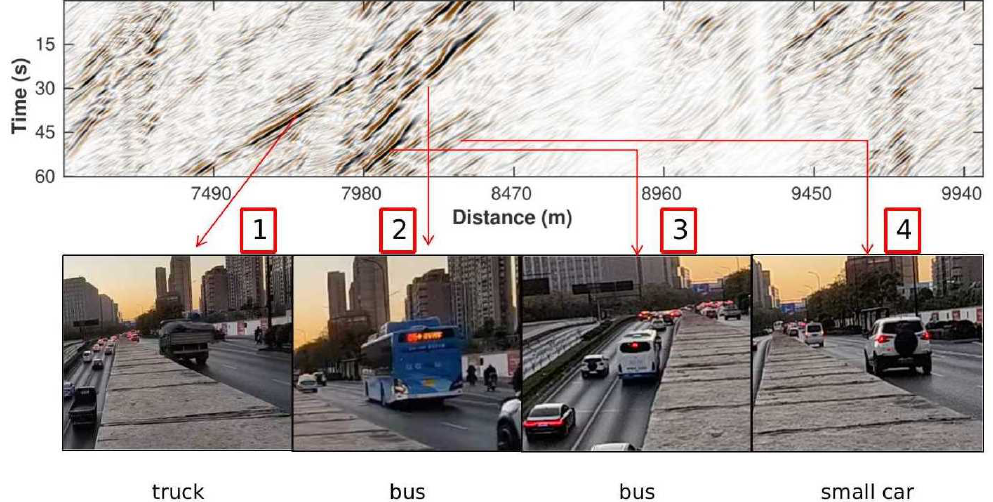
Figure 15. The processed west-heading events and their corresponding vehicles. Panels 1–3 show examples of large passing cars that induce strong signals, and the last panel shows an example of small car related to weak